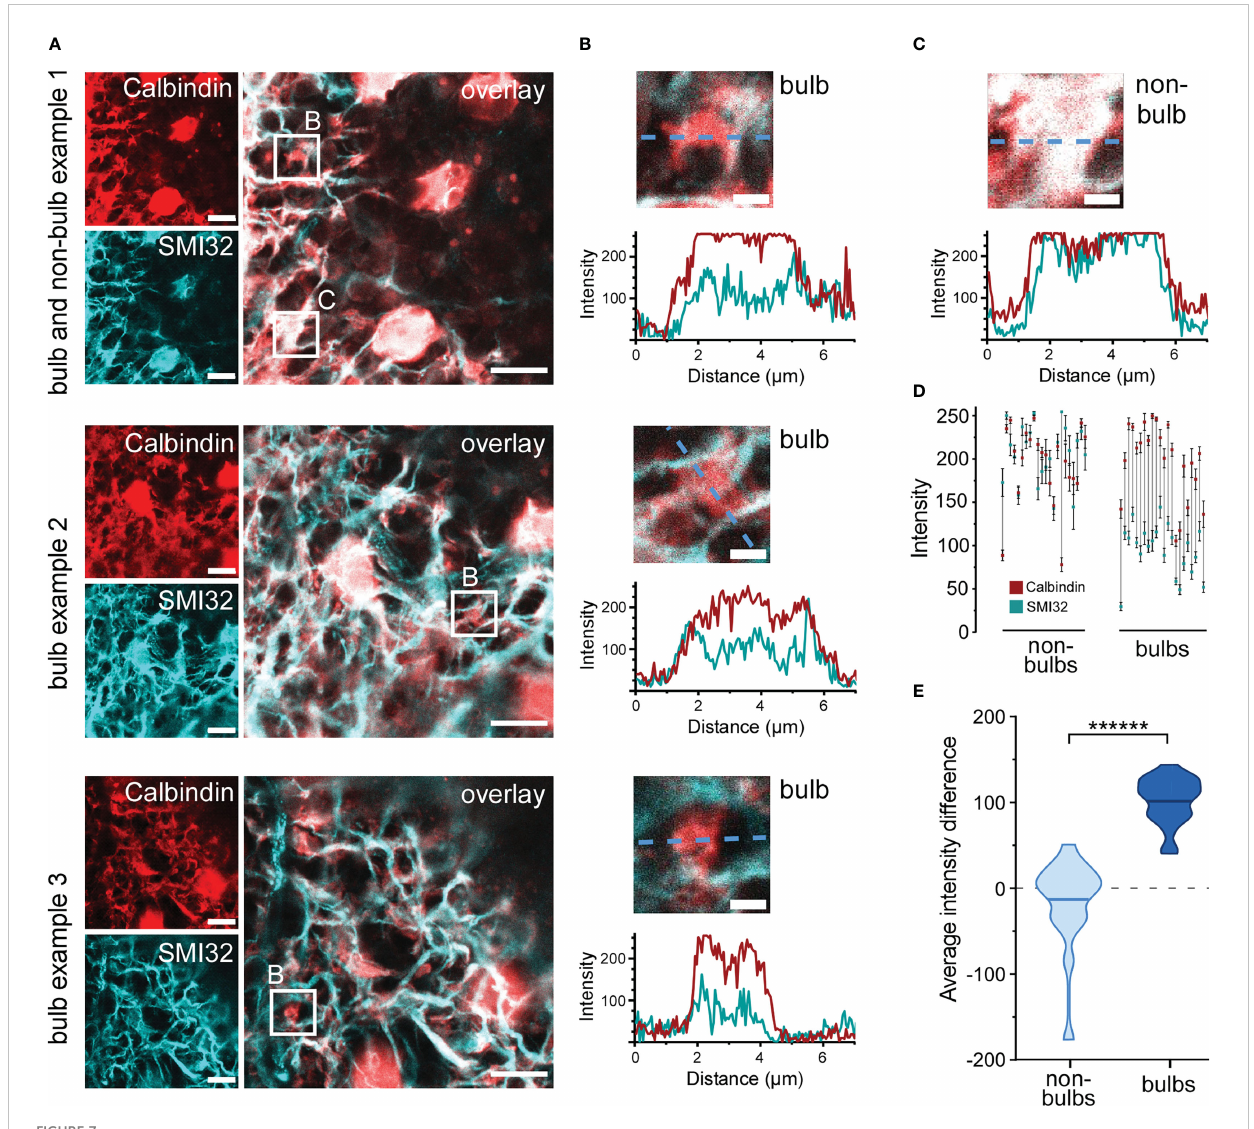
FIGURE 7 Identi fi cation of dendritic horizontal cell bulbs (A) Three example images showing three HC bulbs and one non-bulb identi fi ed in confocal single plane images z-stack slices. Retinal sections were imaged for Calbindin and SMI32. Bulb structures (bulb) positive for only Calbindin and non-bulb structure (non-bulb) positive for both SMI32 and Calbindin were identi fi ed (small white squares). (B) Intensity values for Calbindin and SMI32 stainings were extracted along a line through the three bulbs taken from (A) Plots show Calbindin and SMI32 intensity distribution across the three bulbs (dashed blue lines). (C) Intensity values for Calbindin and SMI32 stainings of a dendritic non-bulb taken from (A) (top panel). Plot shows Calbindin and SMI32 intensity distribution across the non-bulb (blue dashed line). (D) Mean intensities of Calbindin (red) and SMI32 (cyan) stainings along the lines through individual non-bulbs (left) and bulbs (right). Error bars indicate 95% con fi dence interval. The vertical grey lines connect corresponding Calbindin and SMI32 intensities within the same dendritic structures. (E) Violin plot showing the average intensity difference. Difference per pixel was calculated for multiple bulbs and non-bulb control structures, horizontal bars indicate means (n = 1 animal, n = 22 structures for bulbs, n = 22 structures for non-bulbs, p< 0.000001 = ******, Wilcoxon rank sum test). For A and B, the excitation wavelength was 532 nm, and the dye was ATTO532 for SMI32. For Calbindin, the excitation wavelength was 488 nm, and the dye was STAR488. Scale bars: 10 µm in A, 2 µm in